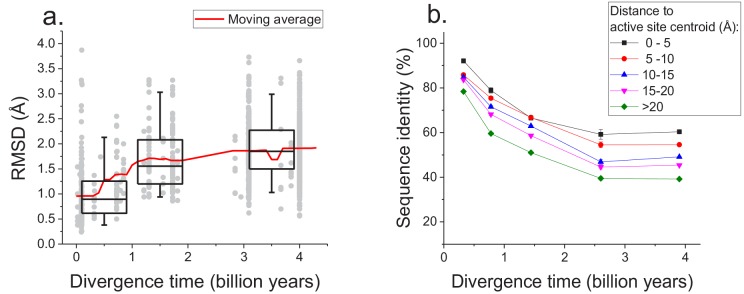
Long-term structural evolution of enzymes with the same molecular function.(a) The pairwise C-alpha root mean square deviation (RMSD) as a function of the divergence time between pairs of orthologs annotated with the same EC number. RMSD values were calculated based on structural protein alignments using the TM-align algorithm (Zhang and Skolnick, 2005). Gray dots represent pairs of considered orthologs, boxes indicate the median and 25–75 RMSD percentiles for the corresponding divergence times, the vertical lines indicate the 5–95 percentiles, and the red line shows the moving average of the data. (b) Long-term divergence of sequence identity of protein sites located at different distances to enzymes’ active site residues. In this analysis we considered the same species and enzymatic activities used to explore the global sequence divergence (Figure 1 and Figure 1—figure supplement 1); the average sequence identities within each distance shell (shown using different colors) were calculated across all pairs of orthologs annotated with the same EC number (see Materials and methods). Error bars represent the S.E.M. across ortholog pairs.10.7554/eLife.39705.021Figure 5—source data 1.RMSD versus divergence times for proteins with the same enzymatic function.